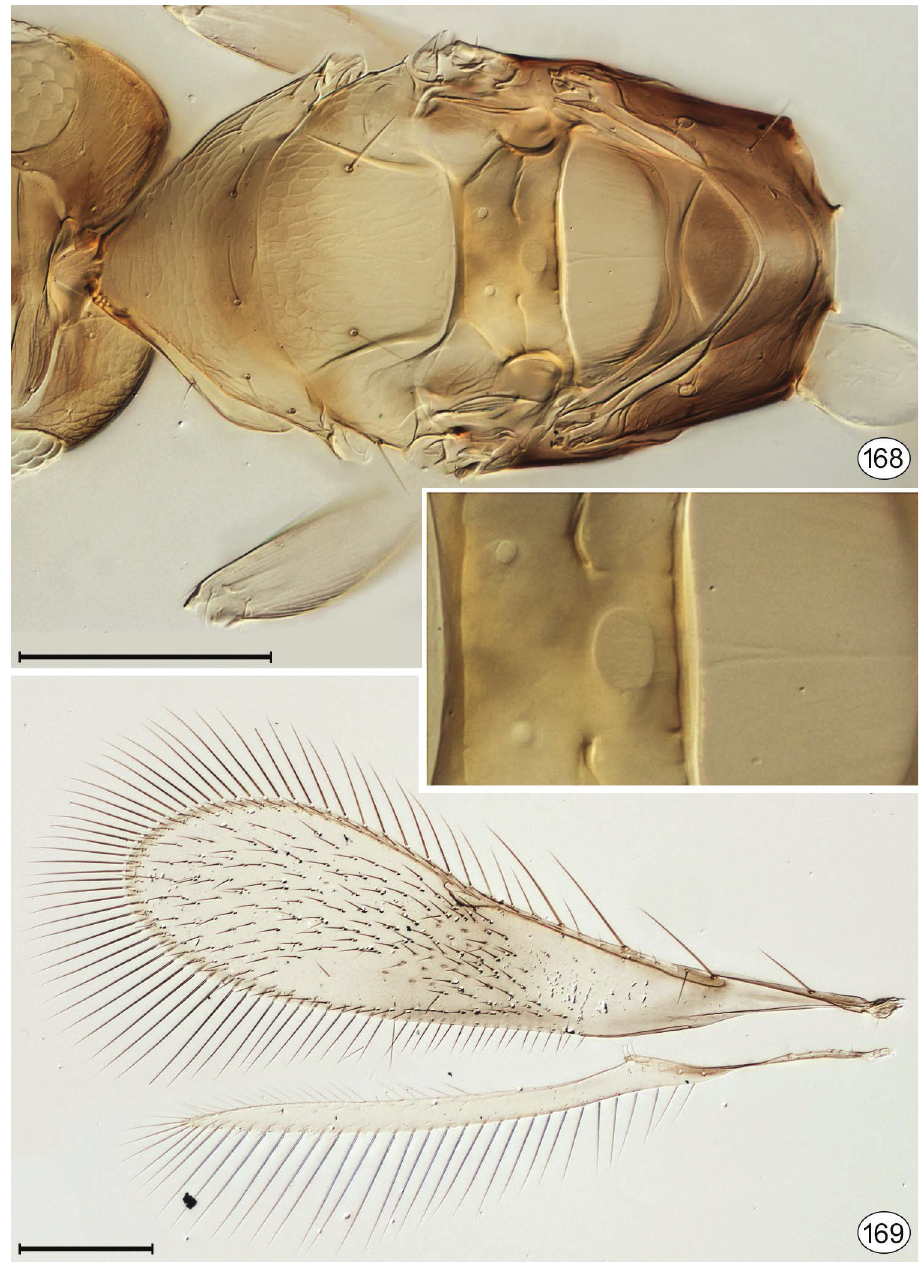
Figures 168, 169. Proarescon similis , holotype. 168 metasoma, dorsal (inset: enlargment of central area of scutellum showing fenestra) 169 wings. Scale bar = 100